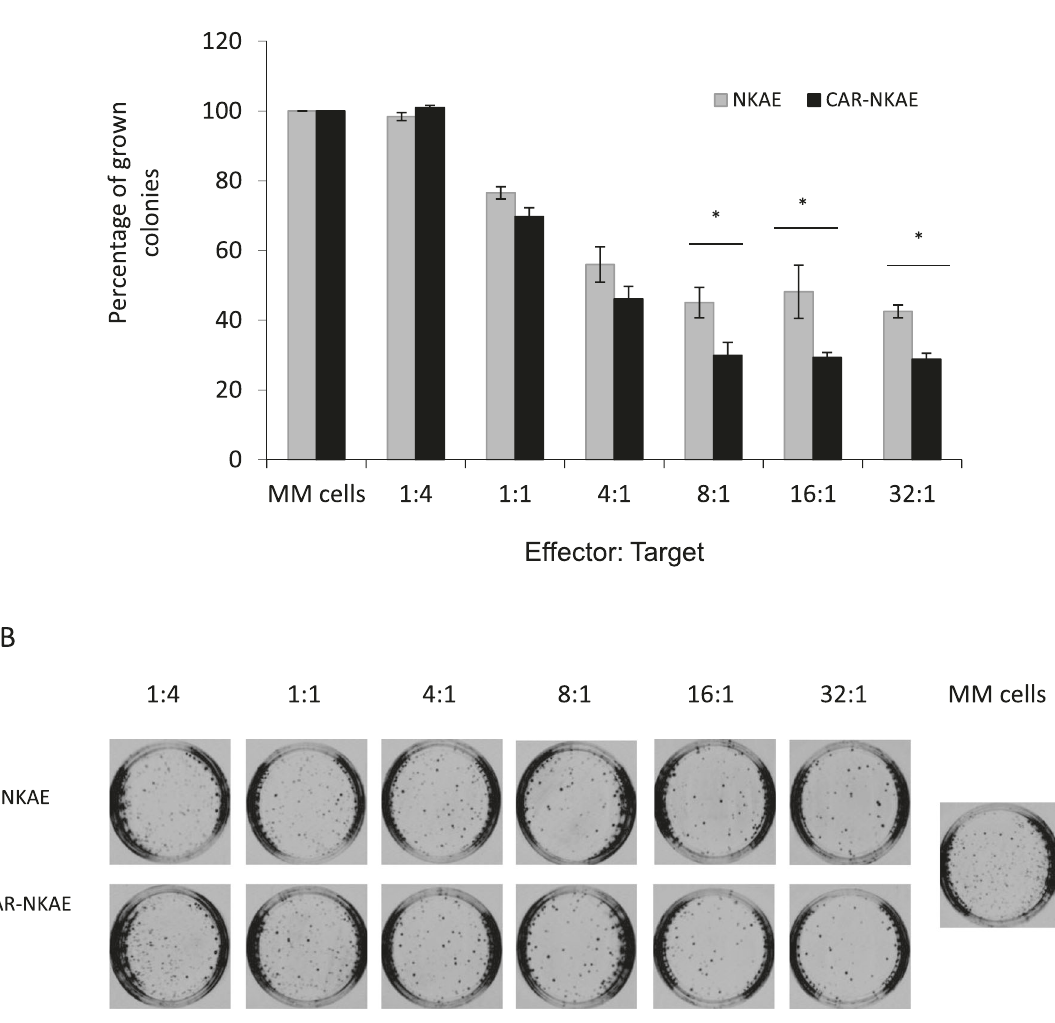
Fig. 6 CAR-NKAE reduces clonogenicity of MM. A L-363 MM cells were exposed to different concentrations of NKAE cells or CAR-NKAE cells (E:T ratios of 1:4 to 32:1) and then seeded in methylcellulose to evaluate the cytotoxicity against clonogenic MM cells. Results are shown as percentage of colonies grown (with autonomous MM growth set as 100%), and represented as mean ± SEM of triplicates. * P < 0.05. B Representative pictures of colonies grown at different E:T